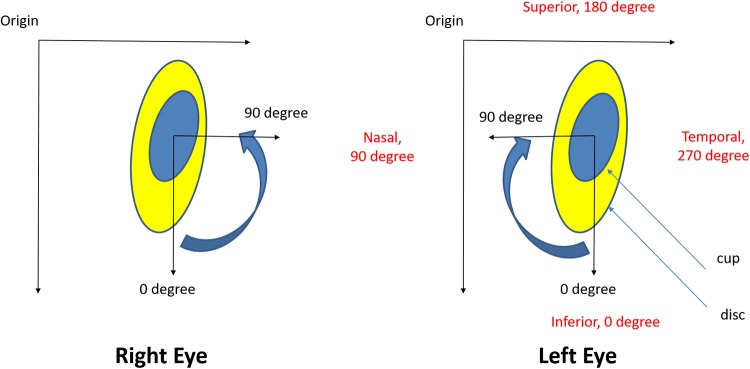
Orientation of the landmarks in the right and the left eye.The centre of the cup is used for the calculations.